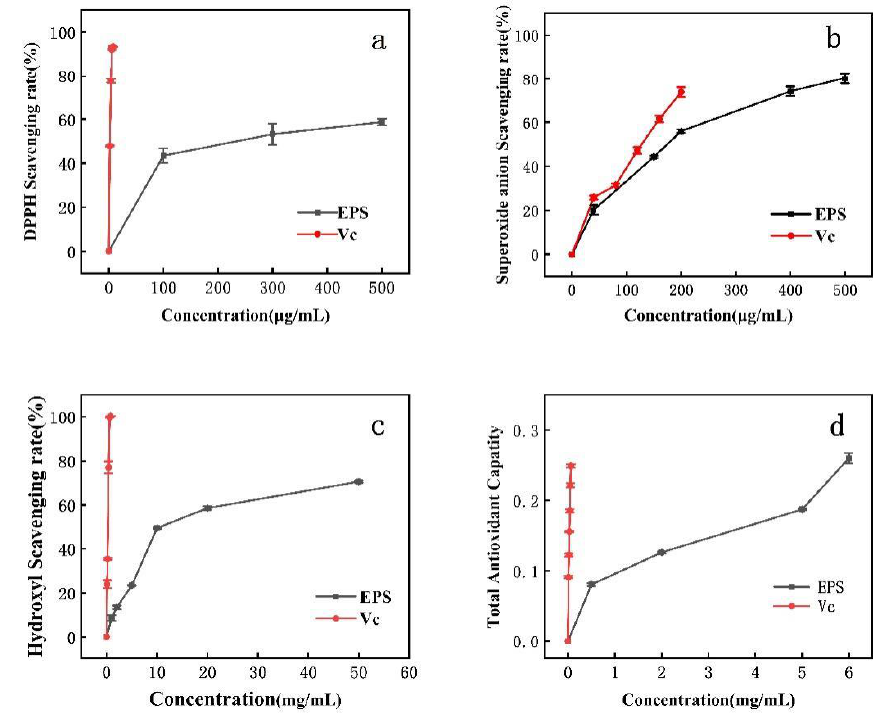
Figure 5. Antioxidant activity of EPS. ( a ): DPPH radical scavenging activity; ( b ): superoxide radical scavenging activity; ( c ): hydroxyl radical scavenging activity; ( d ): reducing